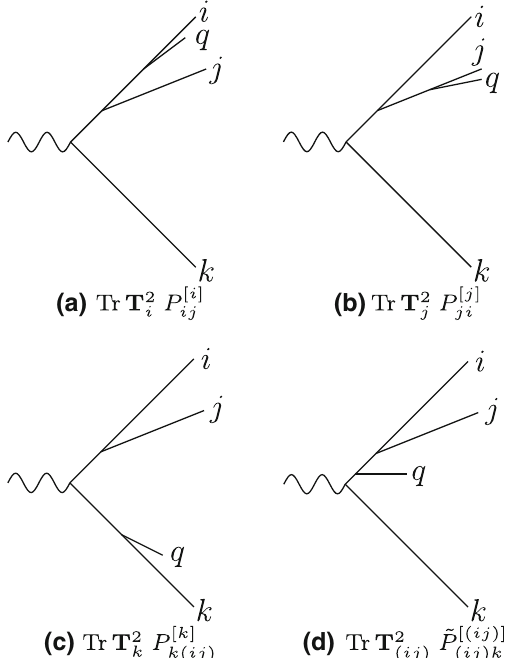
Fig. 2 Diagrams illustrating the angular-ordered interpretation of the four terms in Eq. (9). The relative lengths of lines depict the relative energies. Likewise, the relative angles between lines are